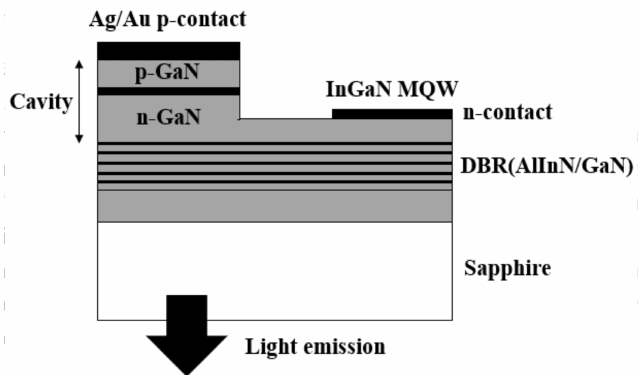
Figure 4. The schematic diagram of a typical RC-LED. Reproduced with permission from [23], John Wiley and Sons, 2004. (Reprinted from Phys. Status Solidi, 201, Dorsaz, J. etc., InGaN/GaN resonant-cavity LED including an AlInN/GaN bragg mirror. 2675–2678, Copyright (2004), with permission from John Wiley and Sons.)